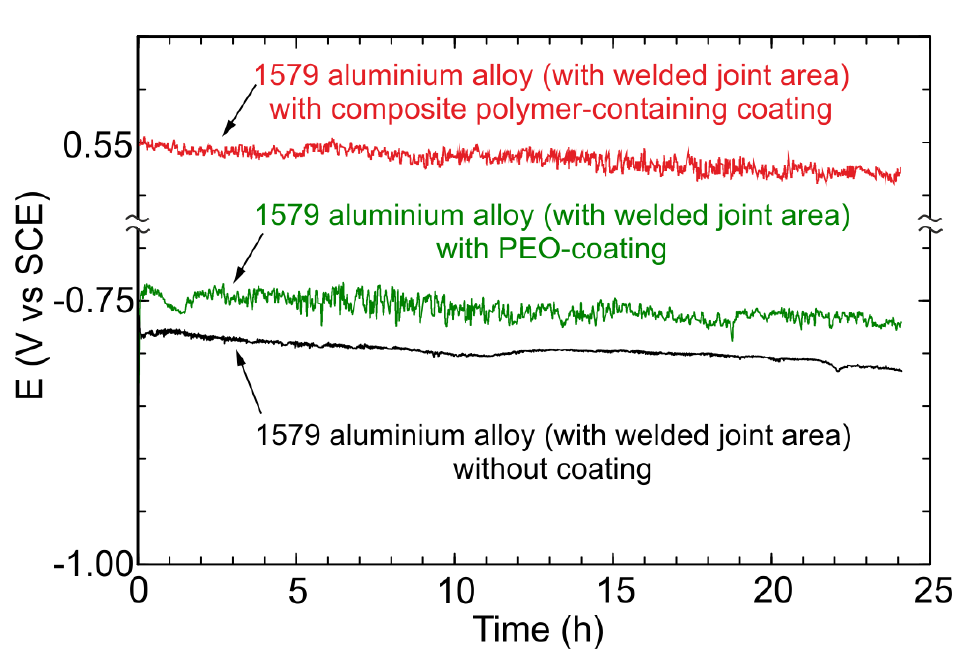
Figure 11. Open circuit potential changing versus time (24 h) for the 1579 aluminium alloy (with welded joint area) samples without coating (the lower curve), with PEO-coating (the middle curve), and with composite polymer-containing coating (the higher curve) obtained in 0.5 M NaCl solution.